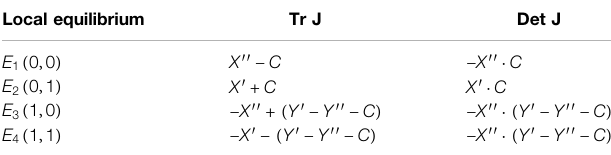
TABLE 3 | Analysis of the local equilibrium. Local equilibrium